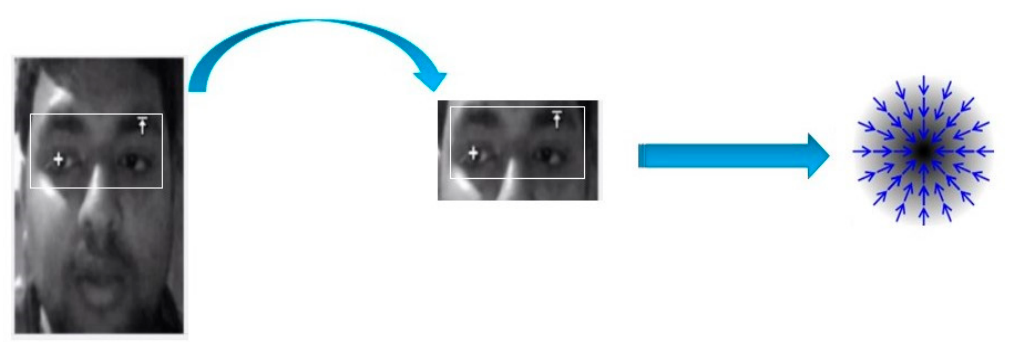
Figure 4. A contrived example is having a dark-colored circle against a light background, similar to an iris and sclera. In ( a ) D k (displacement vector) and G k (gradient vector) do not have same direction but in ( b ) the orientations are same.